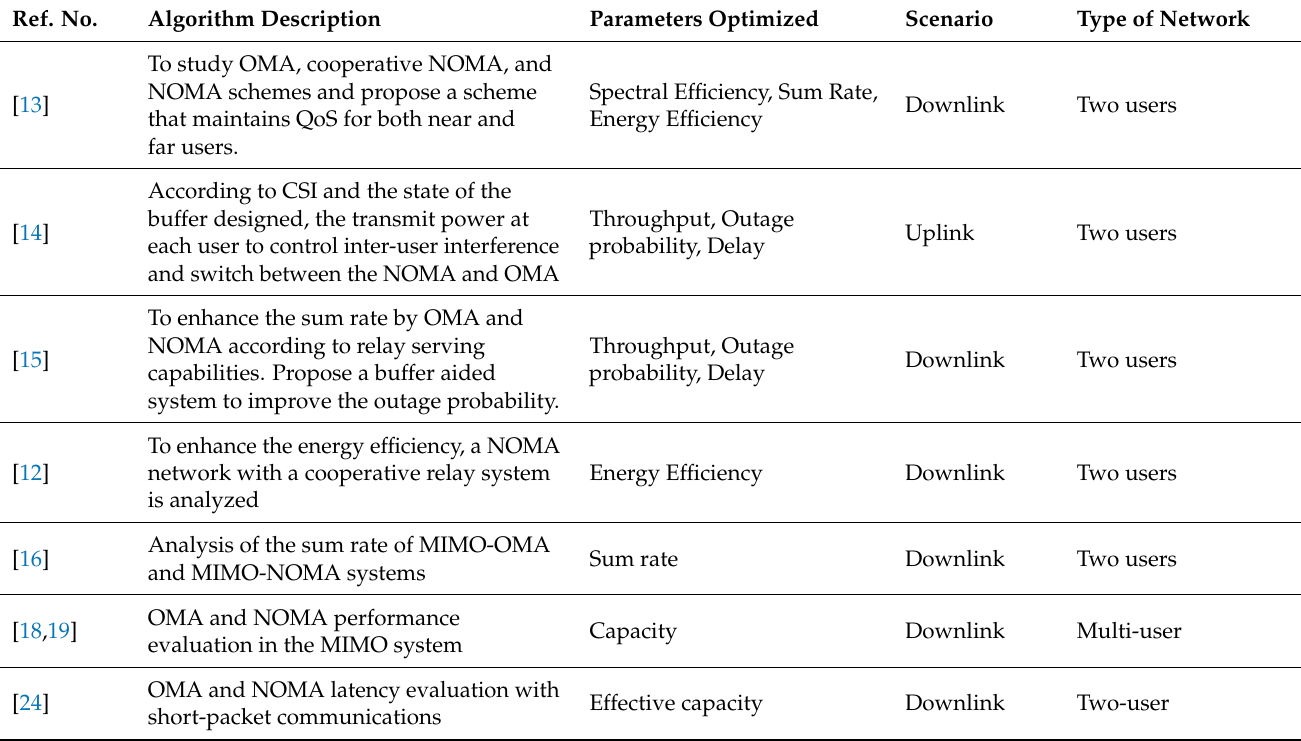
Table 1. Comparative analysis of this paper with existing